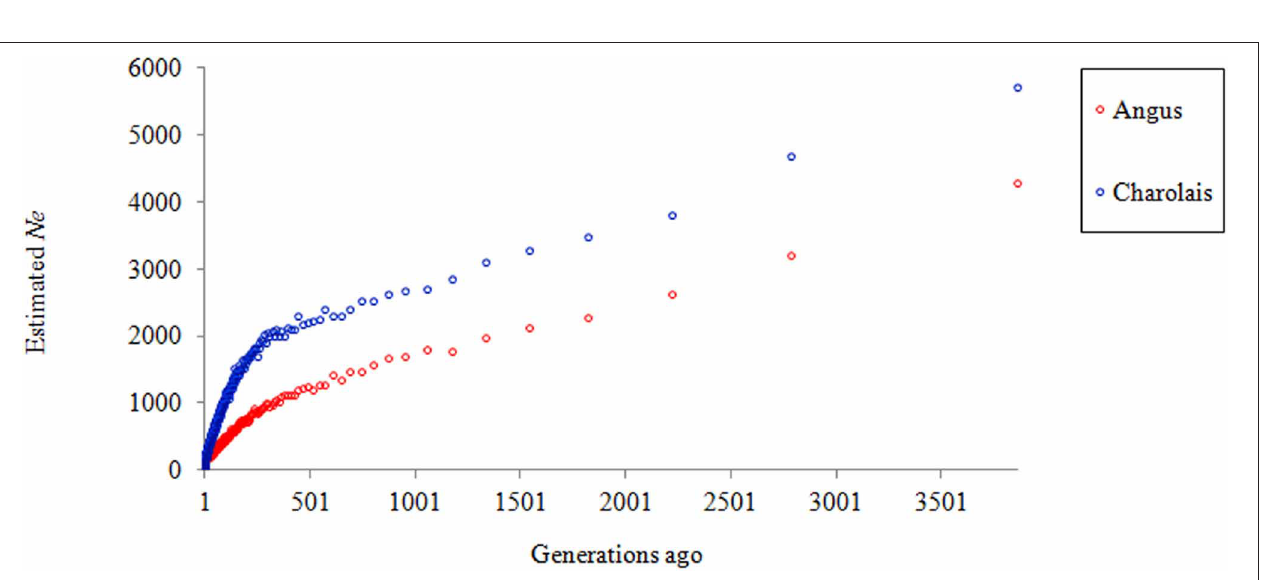
FIGURE 4 | Estimated N e for Angus and Charolais over